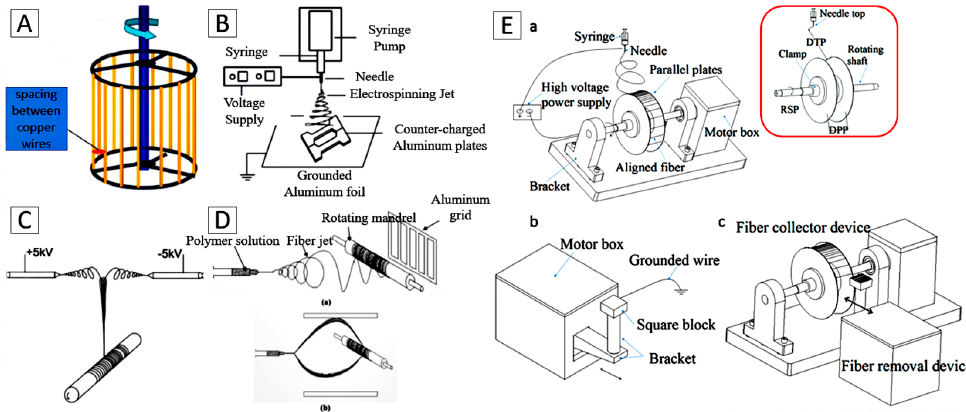
Figure 2. The electrospinning collector for the aligned nanofibers. ( A ) A rotating copper wire drum. Reproduced from [55], with permission from © 2015 The Royal Society of Chemistry; ( B ) Auxiliary electrode/electrical field. Reproduced from [72], with permission from © 2007 American Chemical Society; ( C ) Two spinnerets with opposite voltages and directions. Reproduced from [73], with permission from © 2006 Elsevier; ( D ) Frame collector. Reproduced from [74], with permission from © 2003 Elsevier; ( E ) Parallel double ‐ thin plates collector. Reproduced from [75], with permission from © 2015 Elsevier.